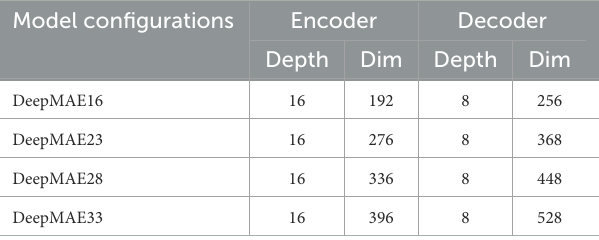
TABLE 2 Four configurations of the